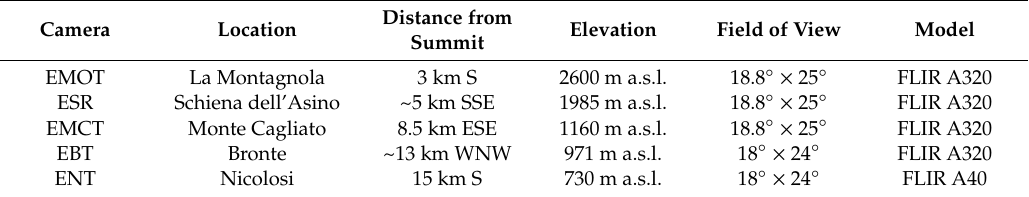
Table 1. Thermal cameras comprising the INGV network installed on Etna. For each camera, the main features are reported (location, distance from the summit, elevation, field of view and